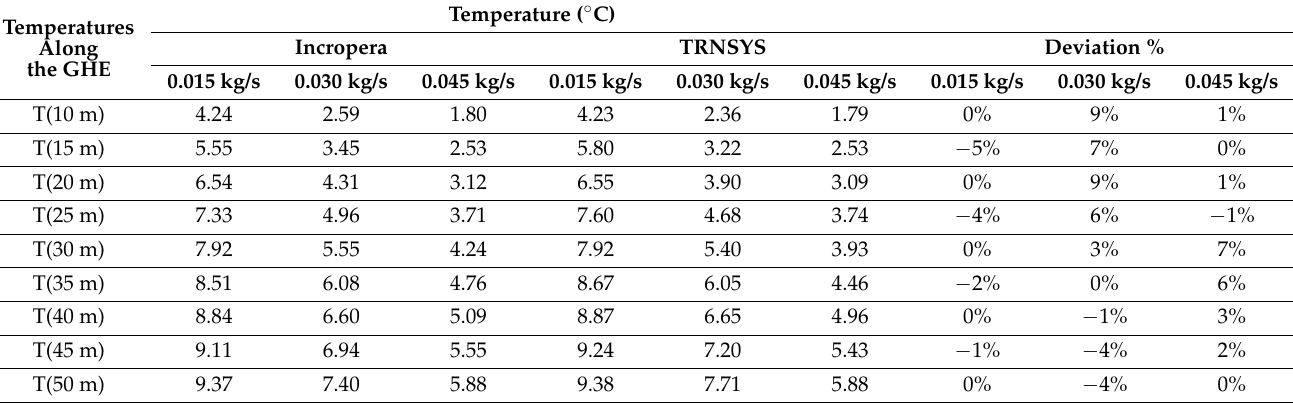
Table 2. The temperature of the fluid at different depths was used in the validation of the GHP simulator results.